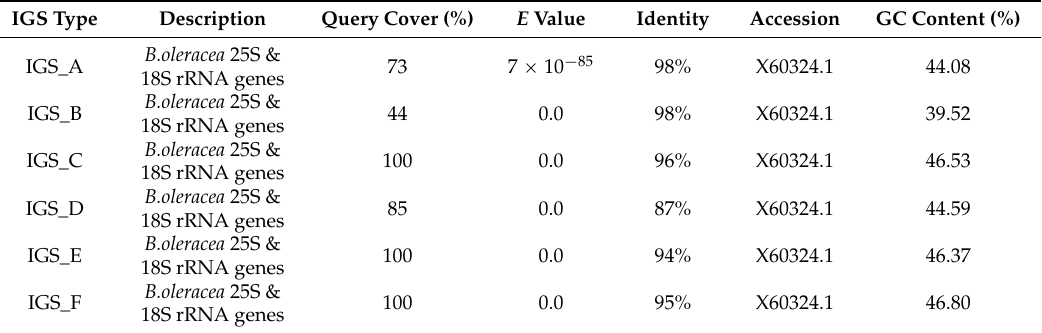
Table 1. Best hit information from Basic Local Alignment Search Tool for nucleotides (BLASTn) of National Center for Biotechnolgoy Information